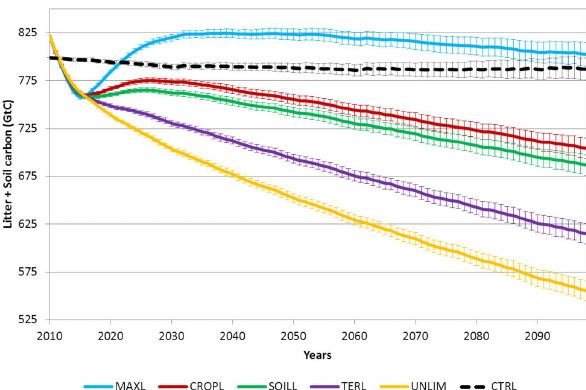
pools of the respective land management scenarios (solid colored lines) compared with that of CTRL (dashed black line). The mean of an ensemble of 19 values is shown by the thick line while the error bars represent the uncertainty (1 standard deviation). After an initial decrease, the carbon pools of soil and litter start recovering as natural grassland is allowed to regrow on areas not used for bioen- ergy cropping. The difference in carbon pools of the different land management scenarios is because of the different extents of land under bioenergy cultivation. MAXL, the most plausible scenario, has the least land under cultivation and thus has the most land under natural grassland. As grassland soils have more carbon than that of woody forests, the sum of litter and soil carbon of MAXL exceeds that of